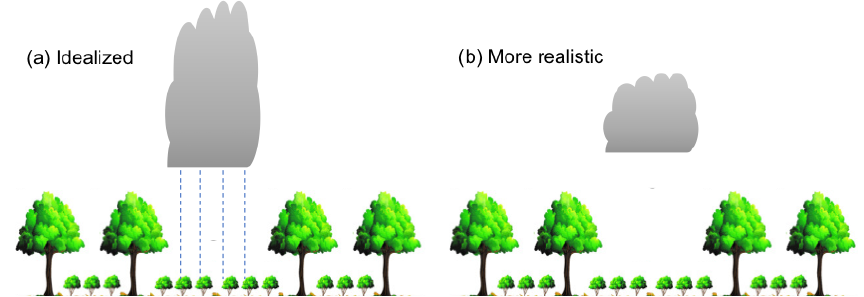
Figure 14. Mesoscale heterogeneity impact on cloud generation in the dry season. (a) Typical perspective regarding the impact of deforesta- tion and clearings generating deep convective clouds and (b) more realistic impact, in terms of mostly a modification of shallow convection cloud cover, impacting radiation more than